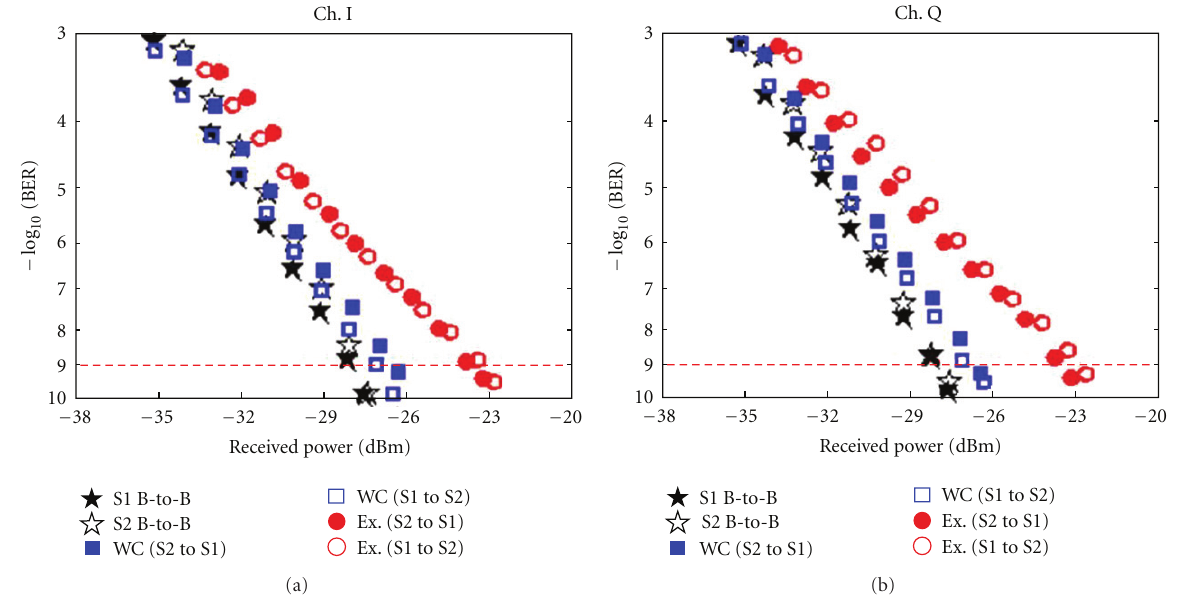
Figure 17: BER curves for the 100Gbit/s DQPSK data exchange.